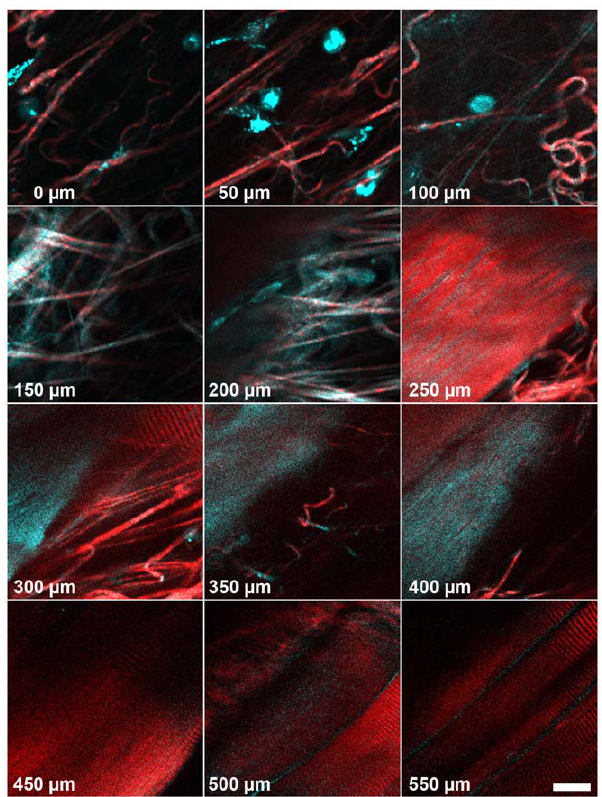
Figure 6. Deep tissue imaging in the mouse thigh muscle with backward GaAsP-detectors. The first 100 m m consist of connective tissue, followed by a dense meshwork of collagen fibers (150 and 200 m m) and finally striated muscle fibers with interspersed collagen. For this display, at each depth a different x,y position from the original 200 6 200 m m stack was selected. Each focal plane was adjusted for brightness individually to compensate for intensity differences. Scale bar is 20 m